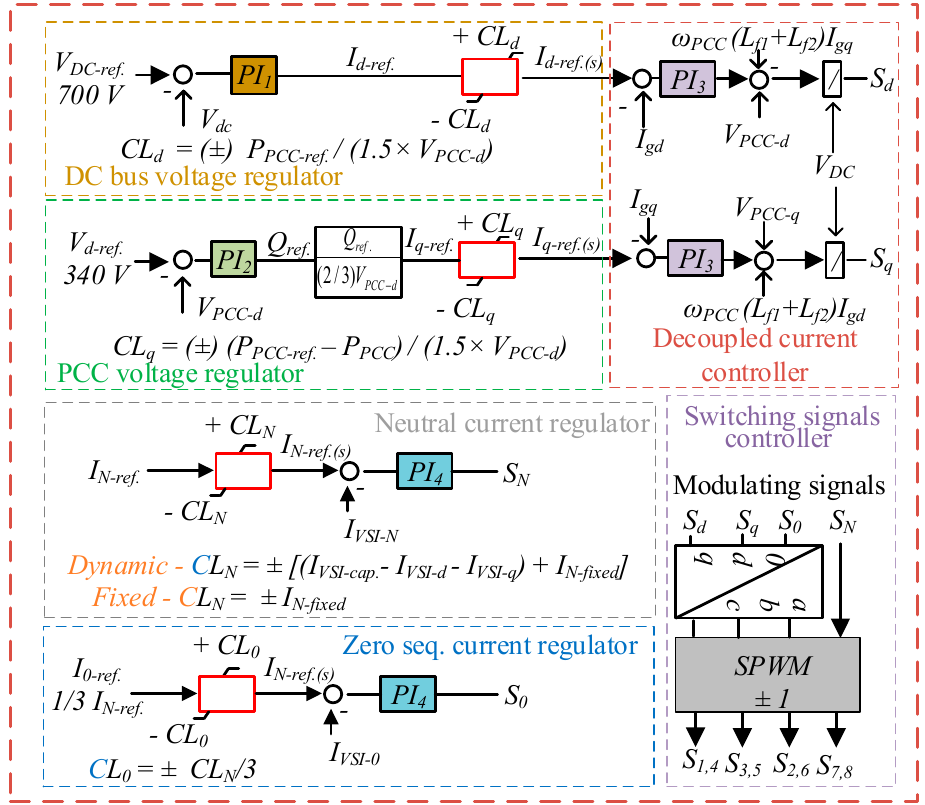
Figure 2. Unbalanced compensation system for Microgrid i (MG i ).